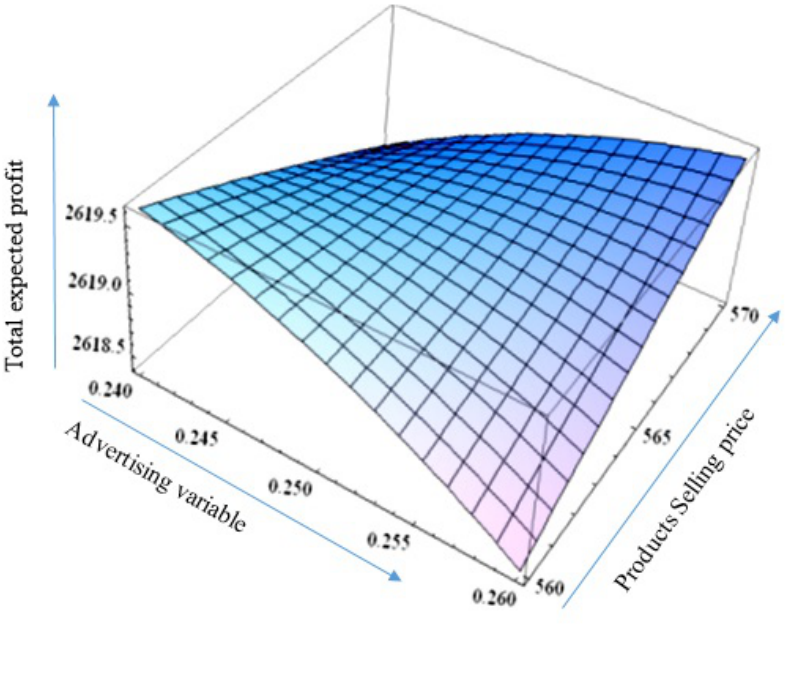
Figure 9. The total expected profit versus the advertising variable and the sale